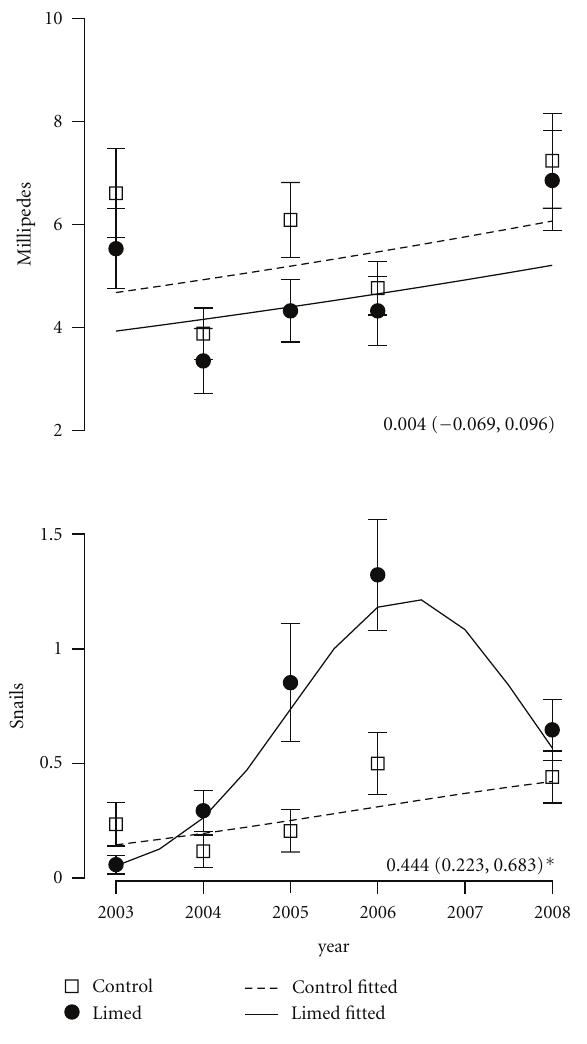
Figure 2: Mean millipede and snail abundance (number per 25 m 2 ) with SE bars on lime-treated and control sites with model lines. Lime treatment was applied between 2003 and 2004 in central Pennsylvania. ∗ Confidence intervals of the time-by-treatment inter- action excluded zero, indicating a significant e ff ect of liming on that variable.